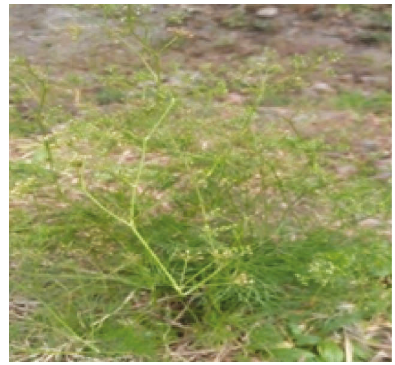
Figure 1: Images of C. leptophyllum plant